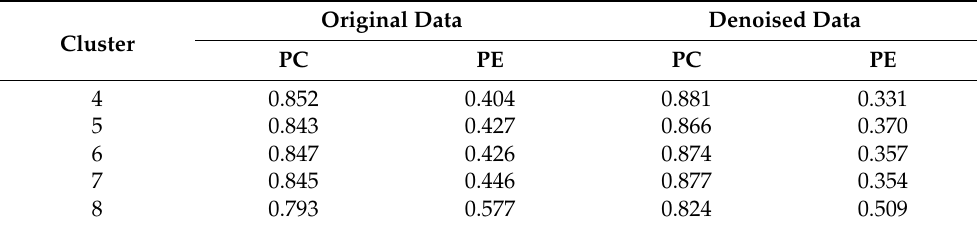
Table 5. Clustering performance comparison of different datasets for Dataset